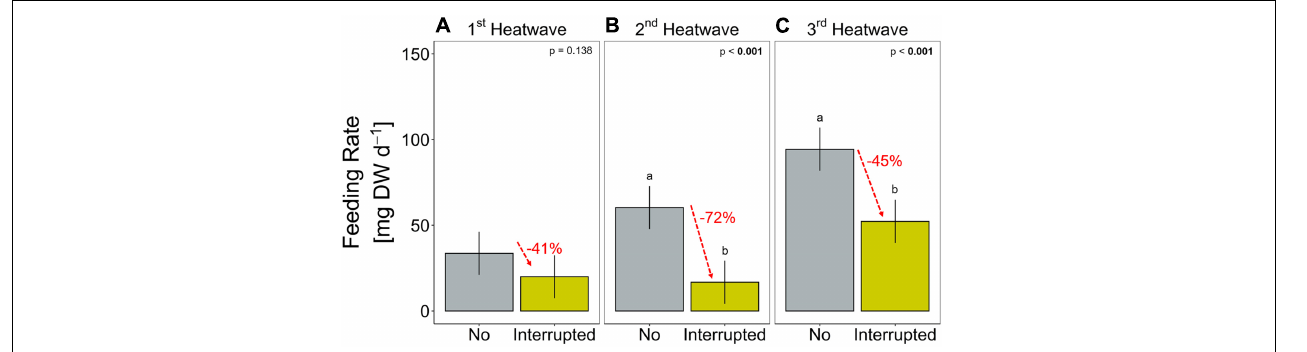
FIGURE 4 | Feeding rate (mg mussel dry weight per day) during each of the three heatwaves of the Interrupted heatwave treatment and the respective period in the No heatwave treatment ( A : 1st, B : 2nd and C : 3rd heatwave period). Data are presented as means (bars) and 95% confidence intervals (whiskers). Lower case letters represent significant differences between treatments based on Tukey post hoc comparisons. Percental differences between means are given in red. Detailed statistical outcomes are given in Table 4